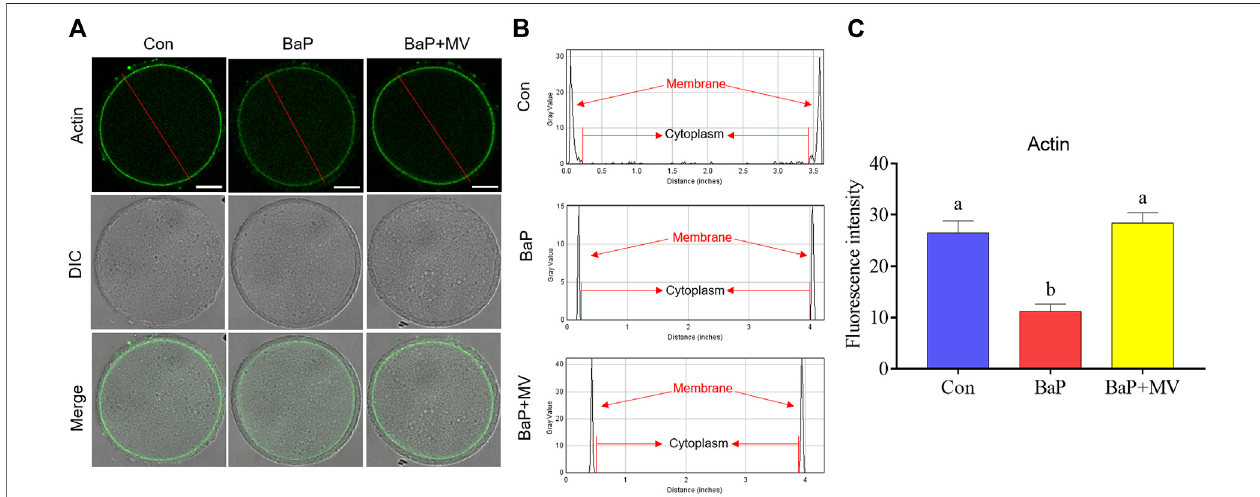
FIGURE3| EffectsofMVonactindynamicsintheoocytesofBaP-exposedmice. (A) Representativeimagesofactin fi lamentsinCon,BaPandBaP+MVoocytes. (B) The distribution of actin fl uorescence signals in the oocyte membrane cytoplasm. (C) The fl uorescence intensity of actin signals in the Con, BaP and BaP + MV groups. Scale bar (cid:2) 25 μ m. The data are presented as the mean ± SEM. a-b Means not sharing a common superscript are signi fi cantly different ( p < 0.05).